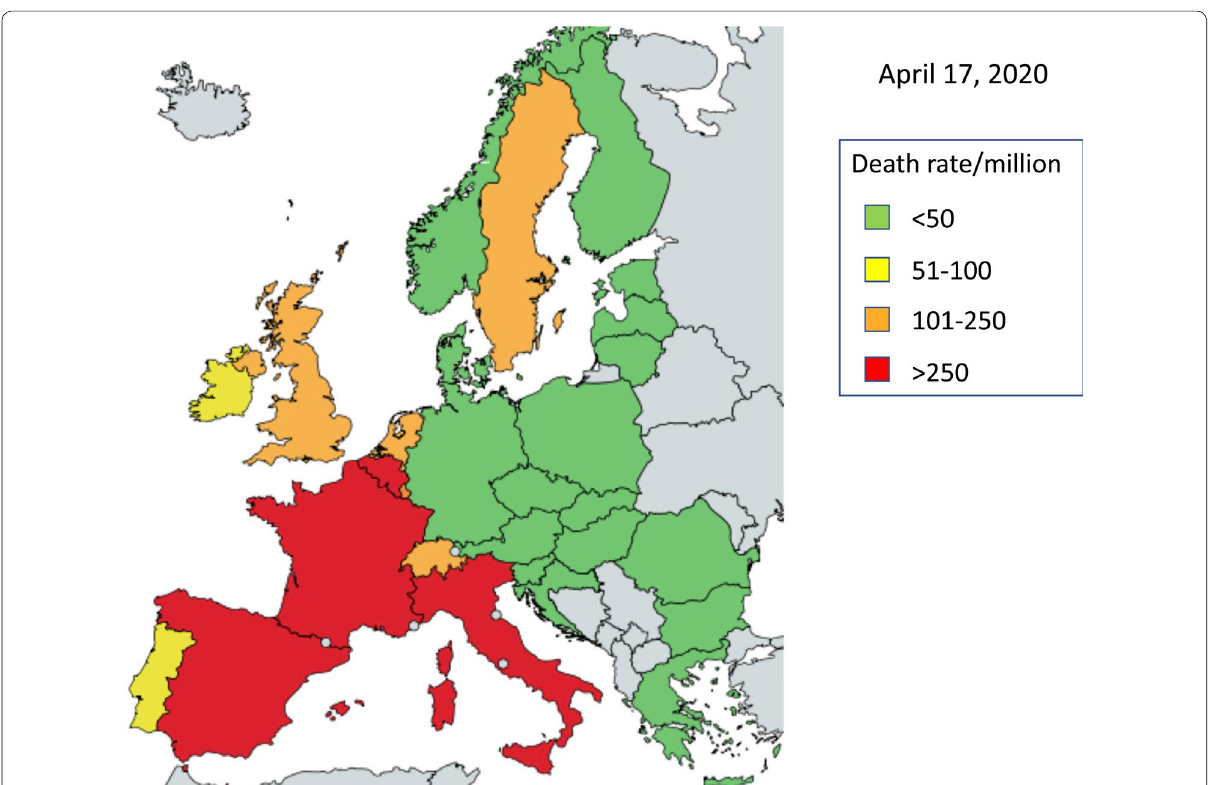
Fig. 1 COVID‑19 deaths per million inhabitants in Europe (April 17, 2020). For France, deaths included hospital and extra‑hospital